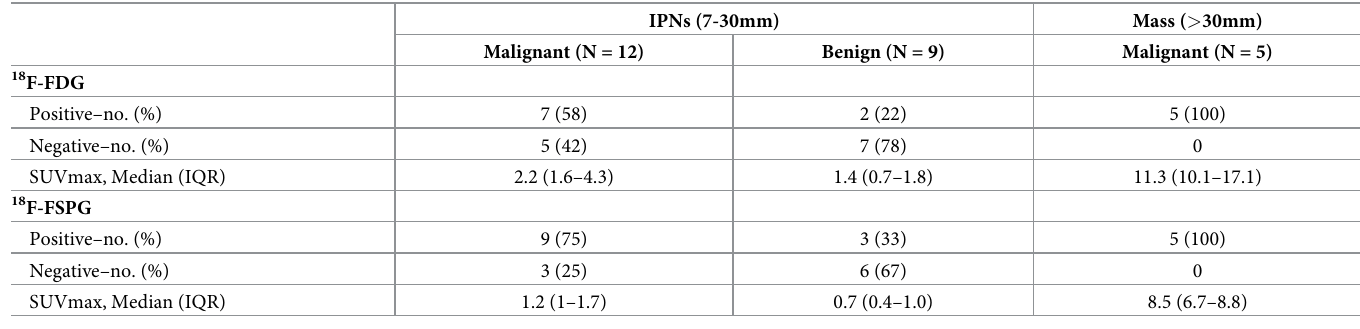
Table 2. 18 F-FSPG and 18 F-FDG evaluation of primary